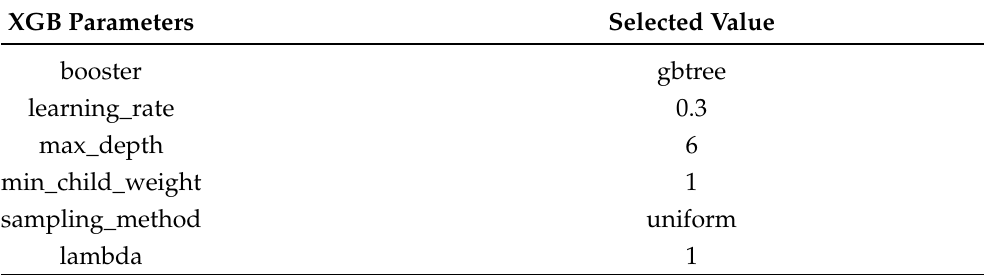
Table 2. XGB classification